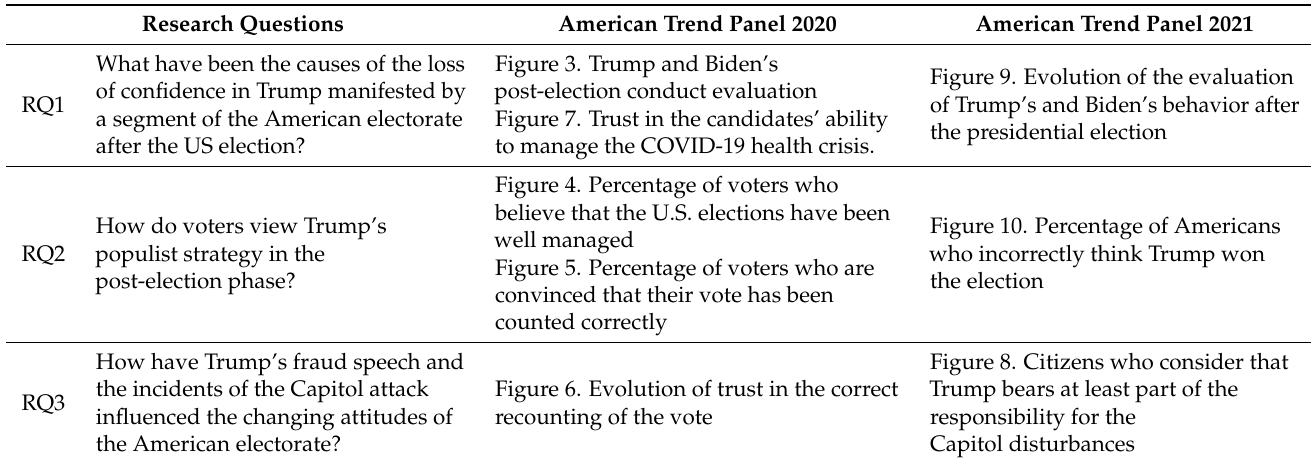
Table 1. Research questions and proposed analysis.